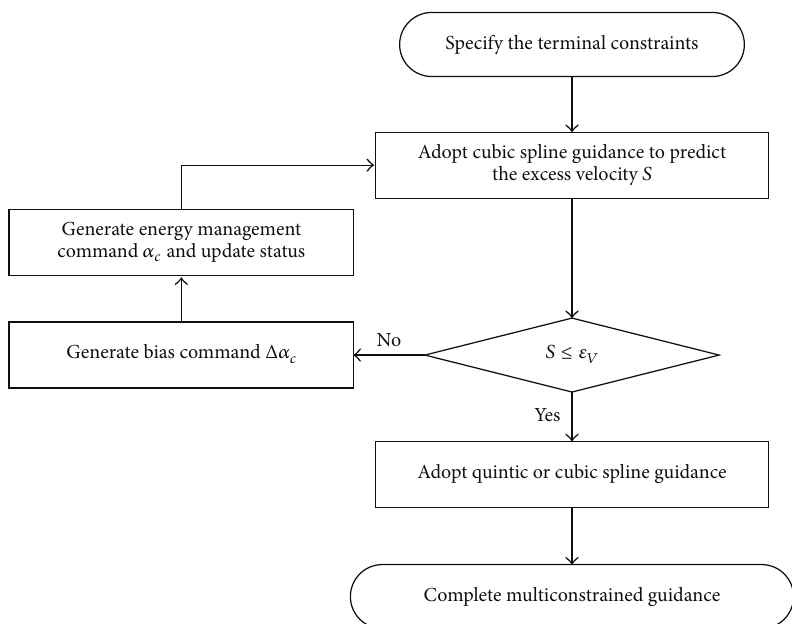
Figure 8: Flow chart of multiconstrained closed-loop guidance.